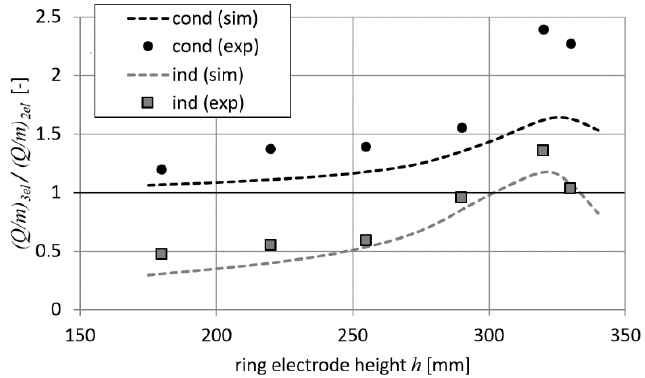
Figure 13. Measured (“exp”) and calculated (“sim”) ( Q / m ) 3 el parameter values for both electrification methods (“ind” and “cond”) in a 3-electrode system, relative to Q / m of a 2-electrode system, as a function of a the ring electrode height h. Simulation results relative to ( Q / m ) 2 el_sim , empirical results relative to ( Q / m ) 2 el_exp.